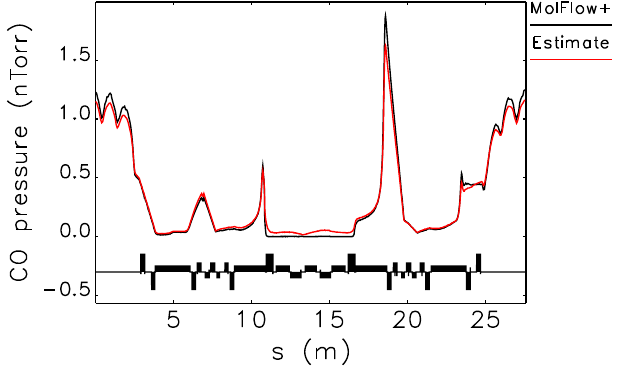
coating.FIG. 5. Comparison of M ol F low+ calculation of the CO partial pressure with the estimate used by the ion code. The conditions are 1000 Ah, 200 mA, and 50% NEG